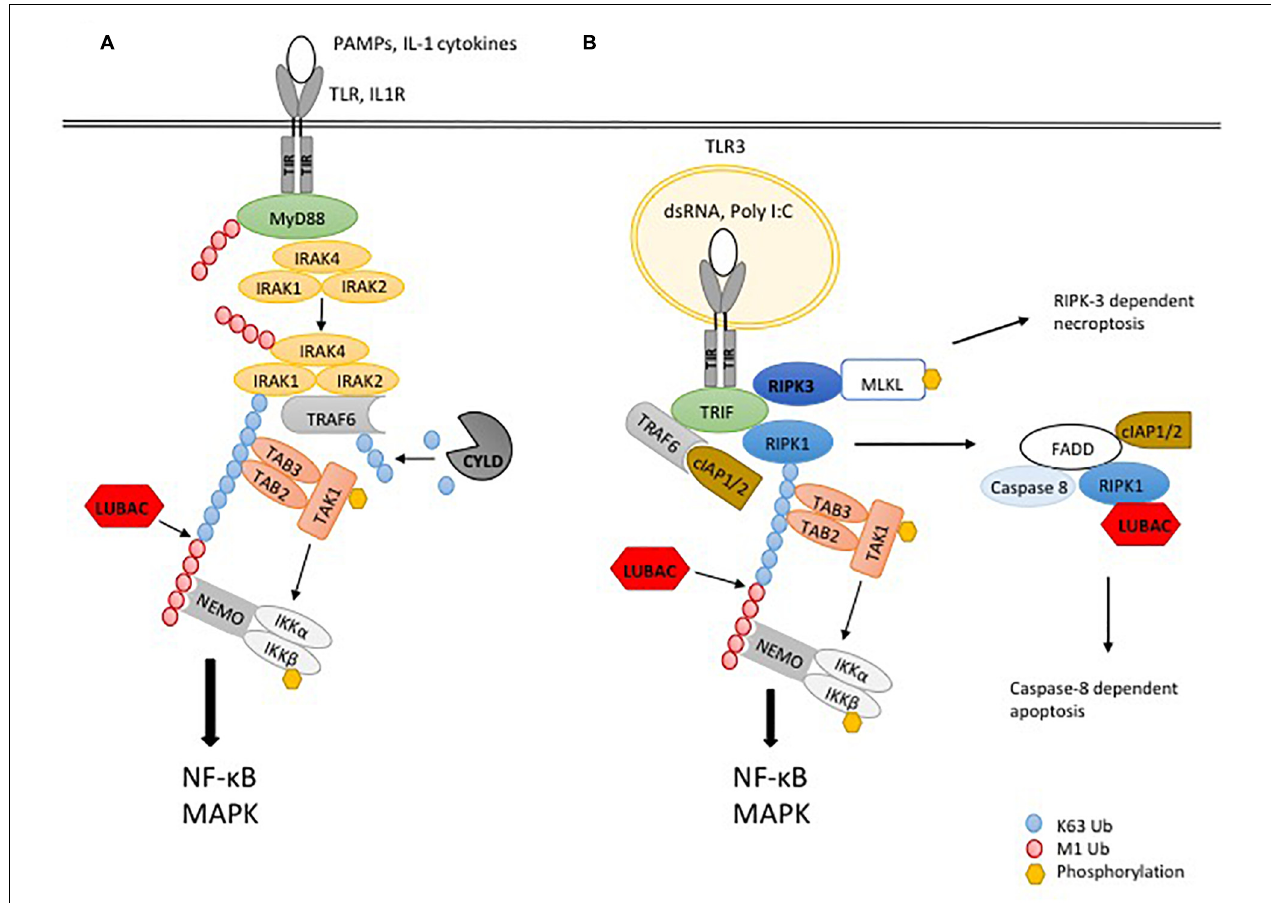
FIGURE 2 | Ubiquitylation in TLR signaling. (A) The recognition of PAMPs or IL-1 α / β by the respective TLR or IL-1R leads to binding of the adaptor protein MyD88, which interacts with the TIR domain of the receptor, leading to recruitment of the kinases IRAK4, IRAK1 and IRAK2. Dissociation of IRAK1 and IRAK2 and their interaction with the ubiquitin ligase TRAF6 initiates the formation of K63-linked poly-ubiquitin chains, serving as a platform for recruitment of TAB2 and TAB3 to activate the kinase TAK1 and in turn MAPK signaling. In addition, the ubiquitin ligase LUBAC extends K63-linked poly-ubiquitin chains with M1-linked poly-ubiquitin chains, resulting in recruitment and activation of the IKK complex through its adaptor NEMO. Phosphorylation of IKK β by TAK1 leads to activation of NF- κ B and pro-inflammatory signaling. The DUB CYLD counteracts ubiquitylation by TRAF6. (B) TLR3 signaling works independently of MyD88 but requires the adaptor TRIF. After binding of dsRNA or Poly I:C to the receptor, the kinase RIPK1 is recruited. The ubiquitin ligases TRAF6 and cIAP1/2 generate K63-linked poly-ubiquitin chains to activate TAK1 and downstream MAPK. To induce the activation of IKKs and NF- κ B, LUBAC is recruited to the complex to generate M1-linked poly-ubiquitin chains. If K63- and/or M1-ubiquitylation are blocked, apoptosis is induced by a complex including FADD, caspase-8 and